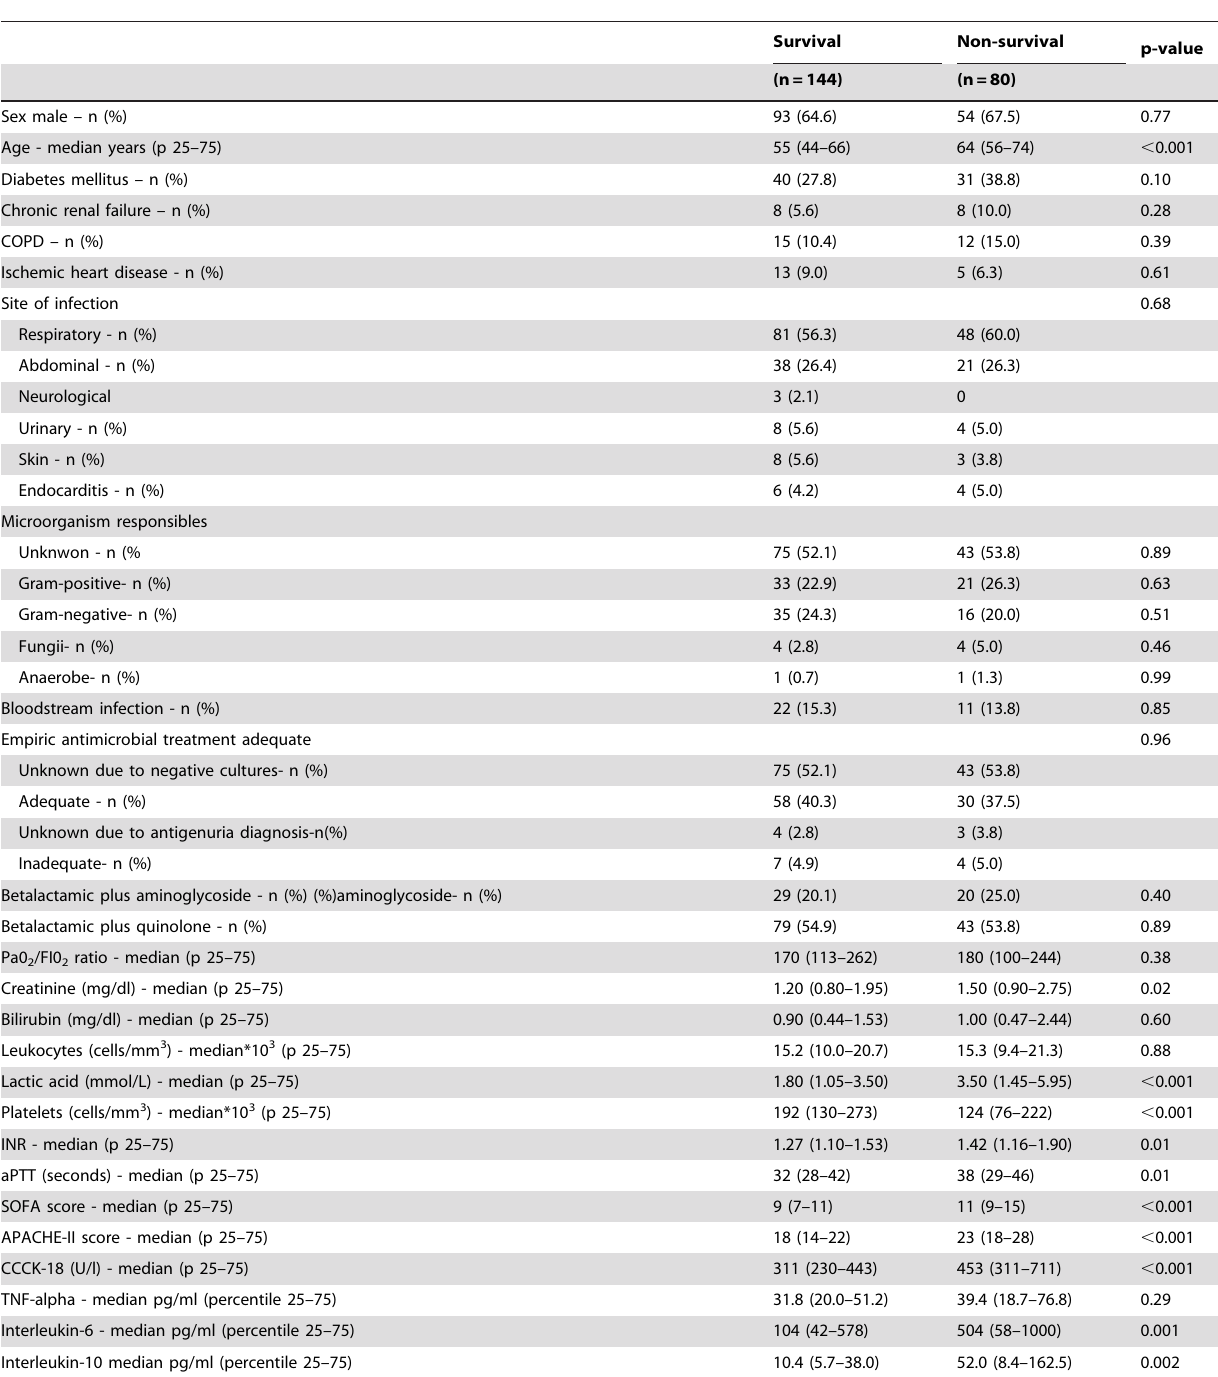
Table 1. Patients’demographic and clinical